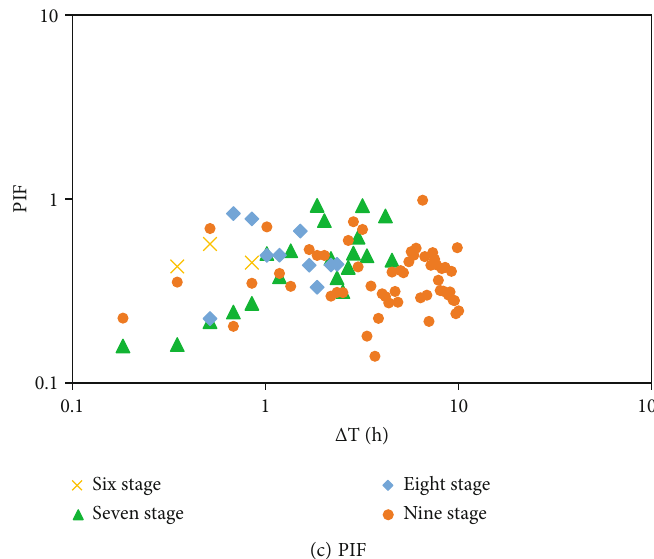
Figure 6: The Δ P , Δ P ´, and PIF for each stage. Well LCG-2 is interfered with by well LCG-3 fractured at stages 6, 7, 8, and